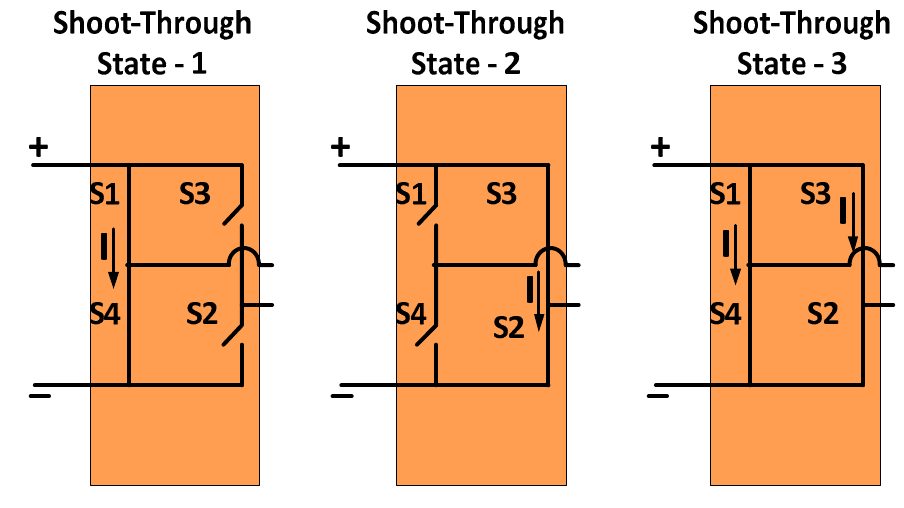
Figure 4. ST zero states. Figure 4. ST zero